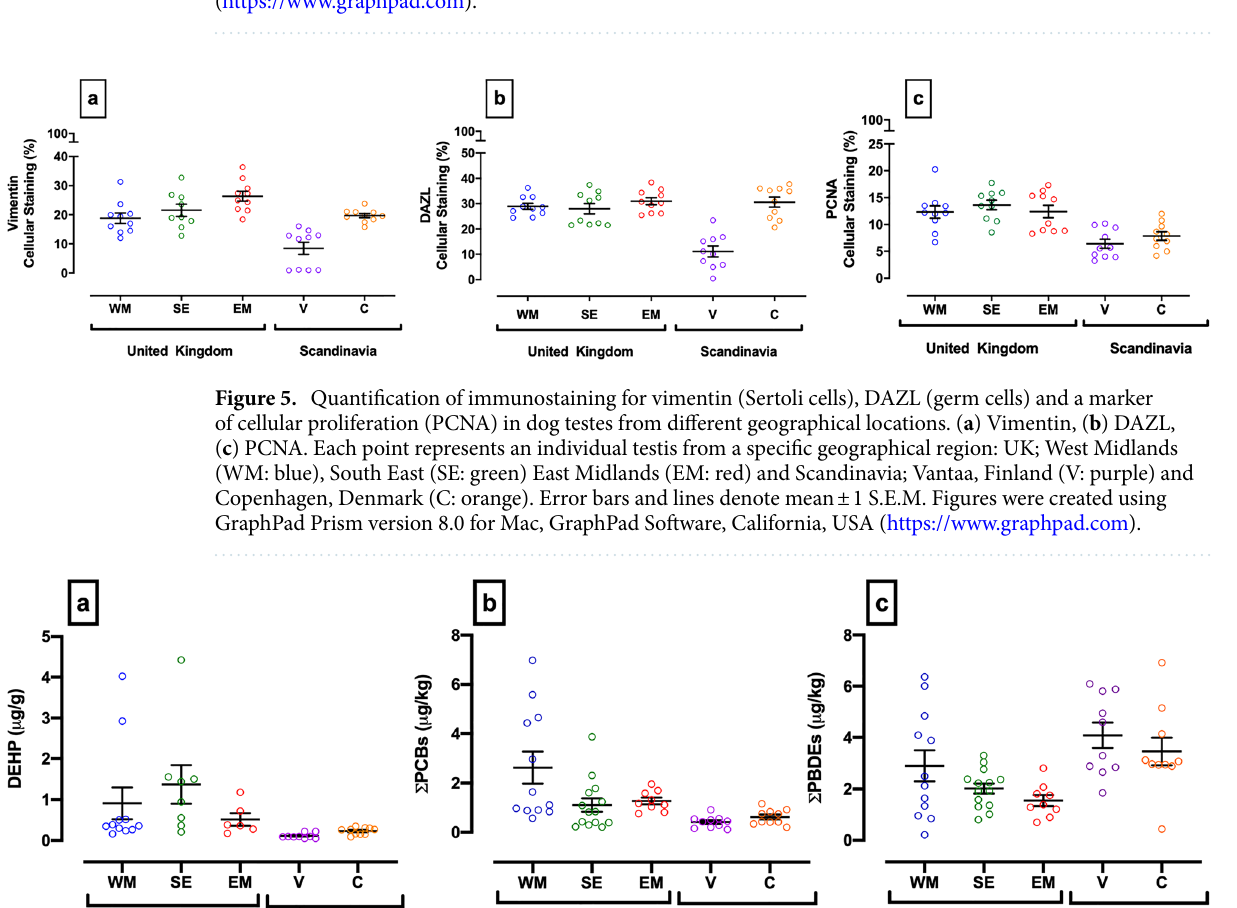
Figure 4. Regional variation in Sertoli cell numbers adjusted for tubular area. Sertoli cells were identified by vimentin immunohistochemistry. Each point represents an individual testis from a specific geographical location: UK: West Midlands (WM, blue), South East (SE, green), East Midlands (EM, red); Scandinavia: Vantaa, Finland (V, purple) and Copenhagen, Denmark (C, orange). Error bars and lines denote mean ± 1 S.E.M. Figure was created using GraphPad Prism version 8.0 for Mac, GraphPad Software, California, USA (https:// www. graph pad. com).